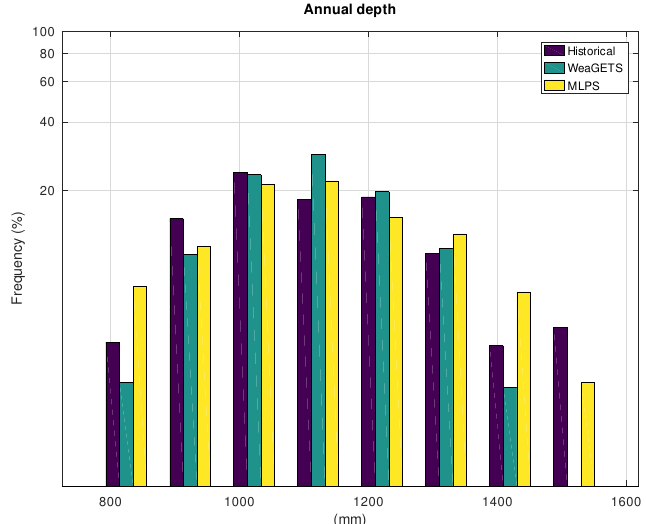
Figure 5. Histogram of the annual synthetic time series (WeaGETS and MLPS) and historical values of the Hohenpeissenberg weather